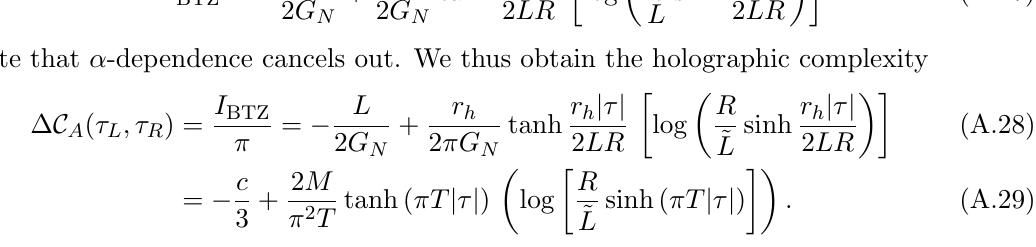
Figure 17 . Plot of [ (cid:25)= (2 M(cid:12) )] C A ( (cid:28) ) with TR = 1 red) and R= ~ L = 2 : 0 (dot-dashed